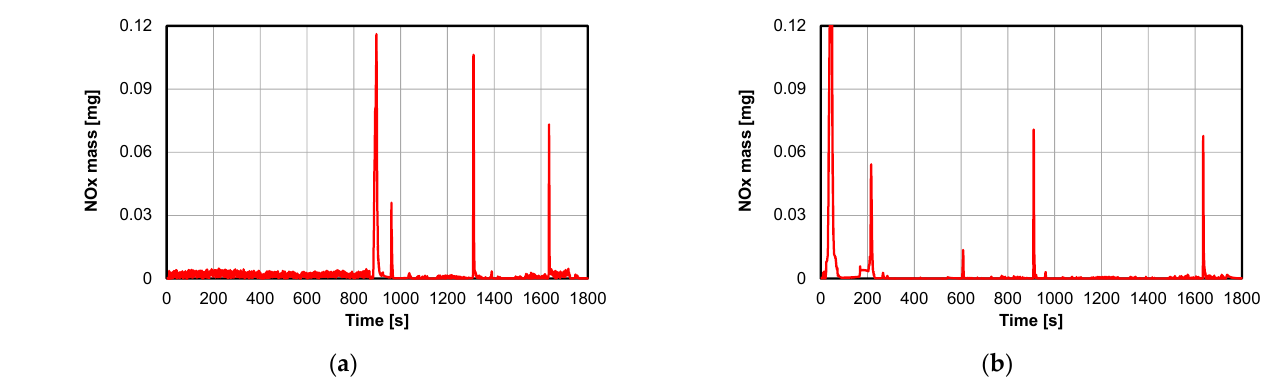
Figure 18. The CO mass versus time for: ( a ) plug-in; ( b ) HEV.